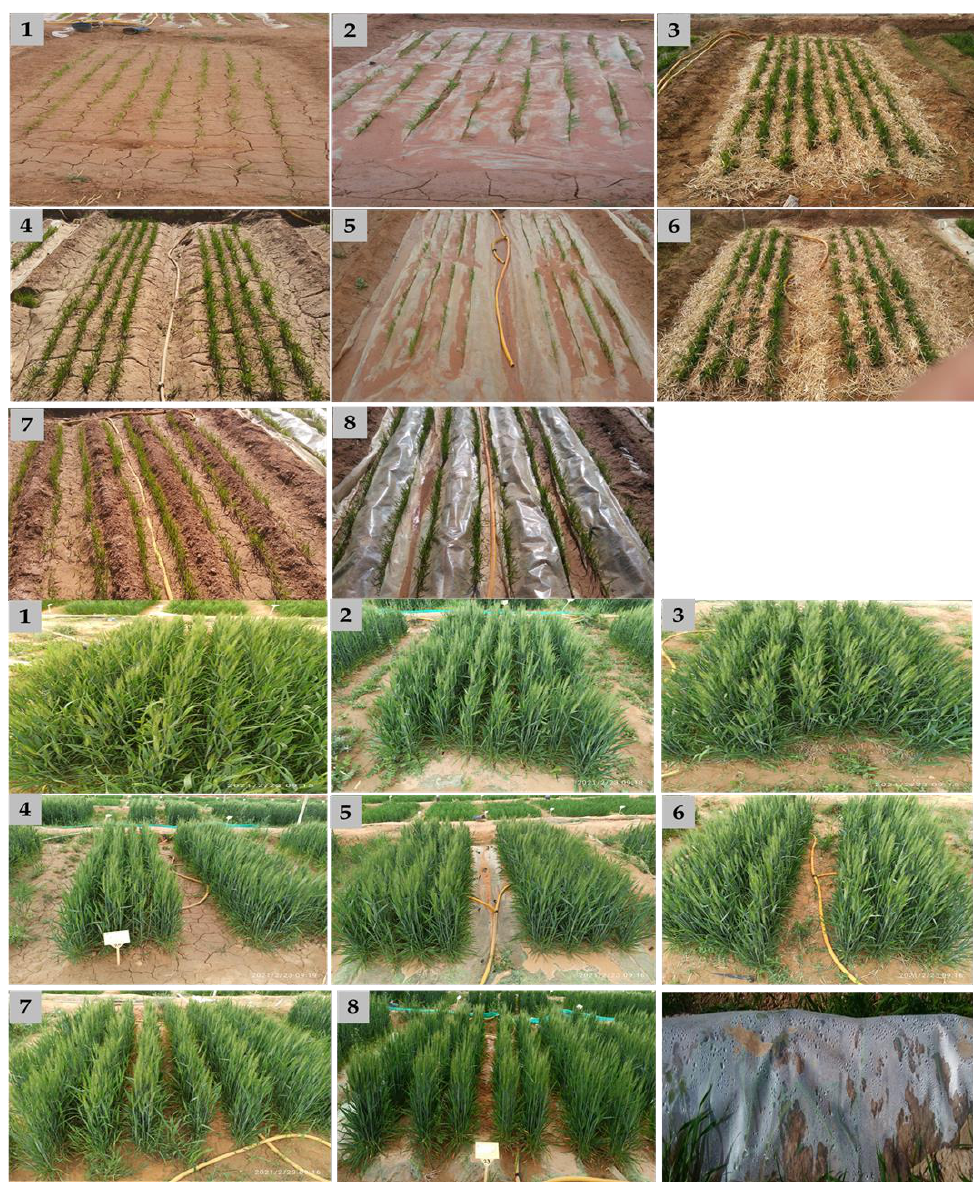
Figure 2. Plot layouts of different combination of planting patterns and mulching at seedling and heading growth stages. ( 1 ) Conventional flat planting (CF) without mulching (CFNM); ( 2 ) CF with plastic film mulch (CFPM); ( 3 ) CF with wheat straw mulch (CFSM); ( 4 ) raised-bed planting (RB) without mulch (RBNM); ( 5 ) RB with plastic film mulch (RBPM); ( 6 ) RB